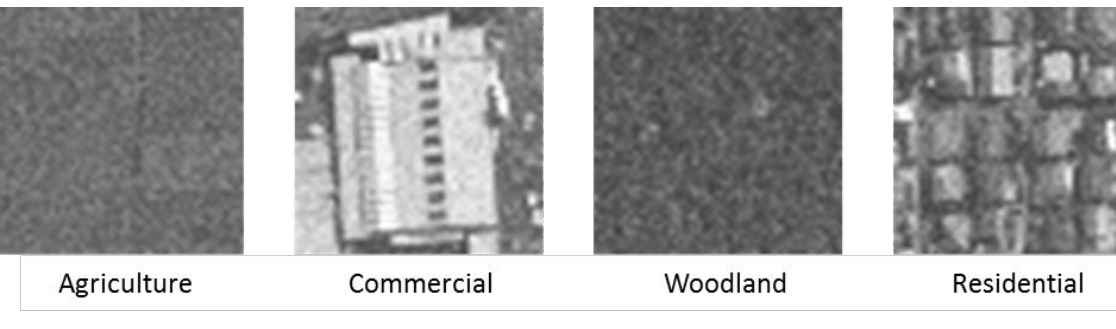
Figure 3. Sample images of four land-use and land-cover classes displayed in the blue